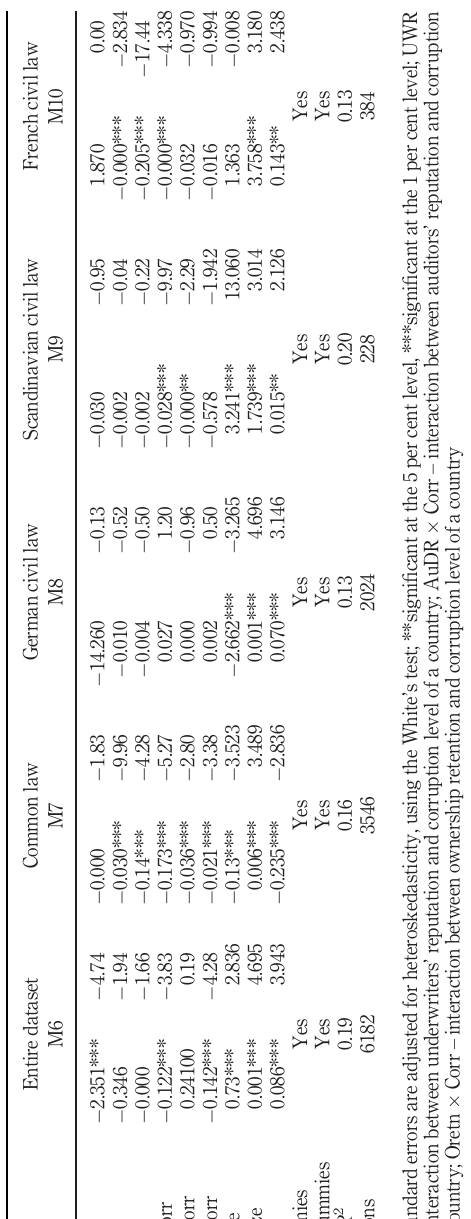
Table VIII. Moderating effect of corruption on the relationship between underwriters ’ / auditors ’ reputation and ownership retention on IPO initial returns in the common and civil law